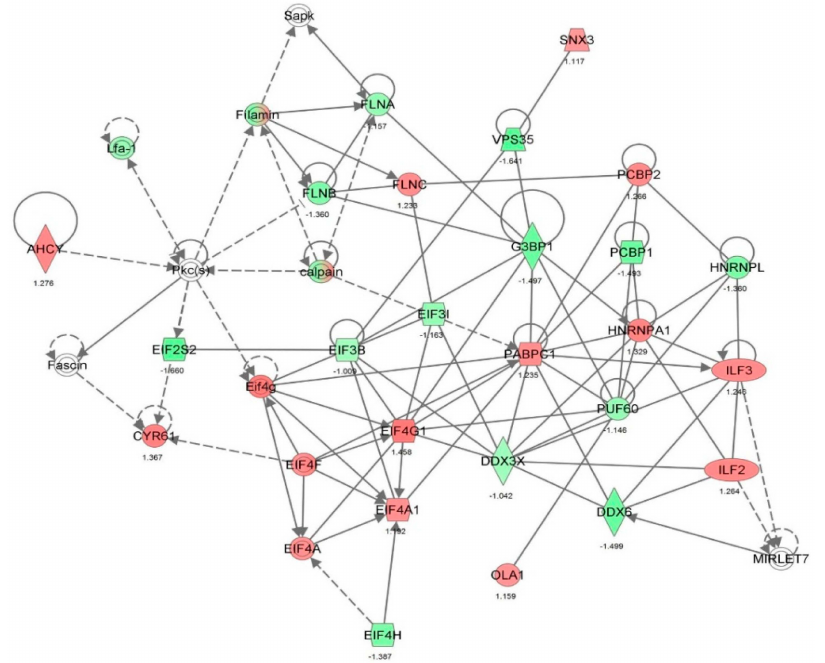
Figure 9. Vancomycin regulated protein synthesis, cellular movement, and gene expression. Red indicates an up-regulation; green indicates a down-regulation. The intensity of green and red colors indicates the degree of down- or up-regulation. Solid arrow indicates direct interaction and dashed arrow indicates indirect